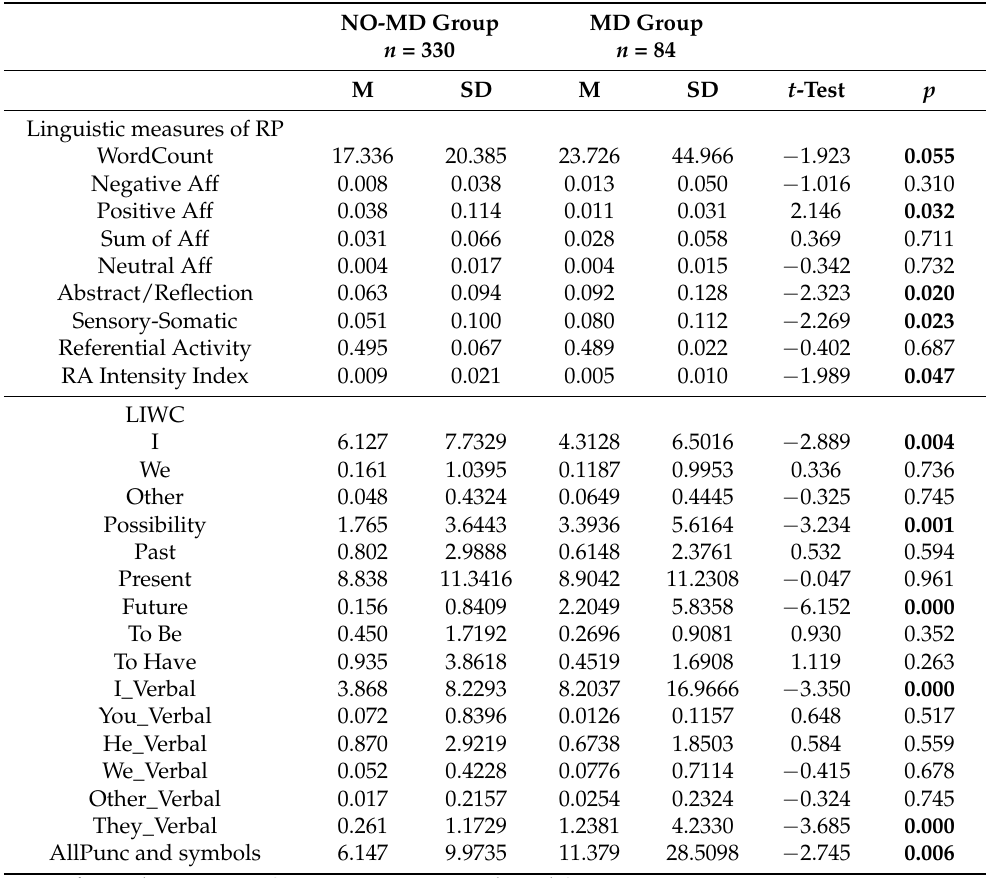
Table 2. Differences in linguistic measures of Referential Process and LIWIC indexes between two